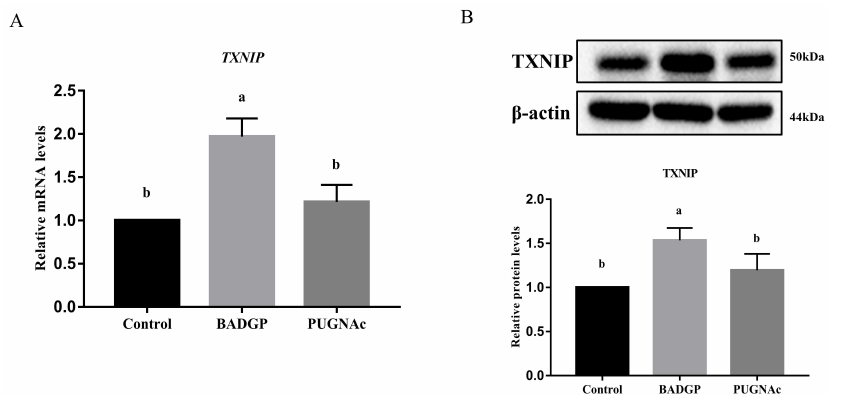
Figure 6. Disruption of O-GlcNAc cycling changes the expression of TXNIP. ( A ) TXNIP mRNA levels by qRT-PCR analysis. ( B ) TXNIP protein levels by Western blot analysis. Values are expressed as mean ± SEM of at least three replicates. Different superscript letters (a, b) indicate statistically significant differences ( p <